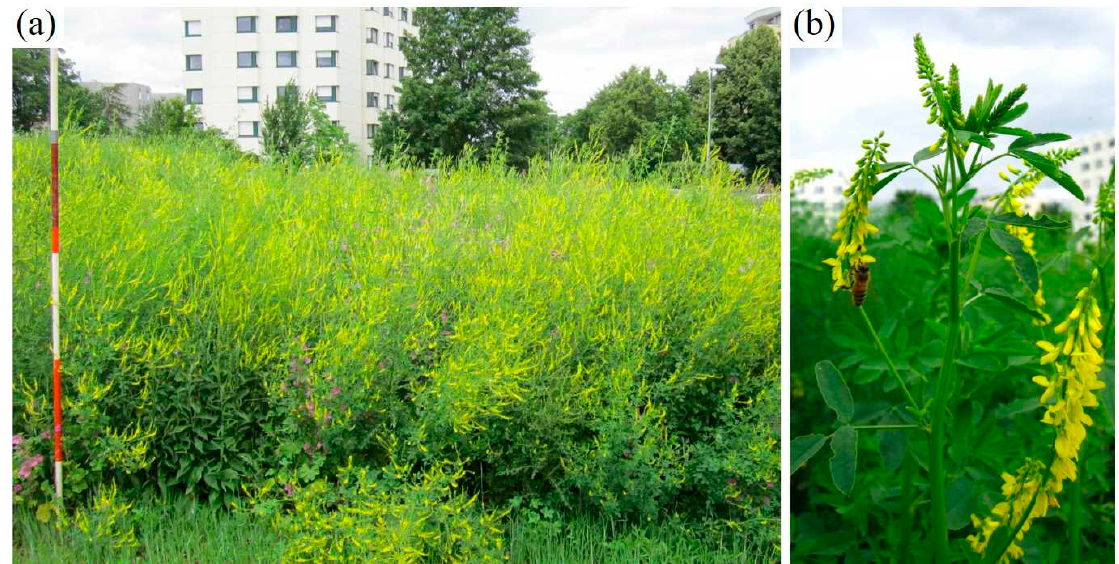
Figure 1. Yellow melilot plant height (50 cm per stick section) in the second year of cultivation ( a ); an inflorescence being visited by a honeybee ( b ) (Source: this study).